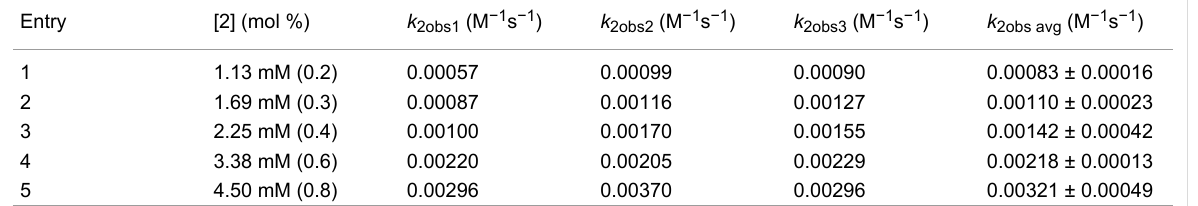
Table 3: Second-order rate constants at 0 °C for the addition of TMSCN to benzaldehyde obtained at different concentrations of complex 2 . a